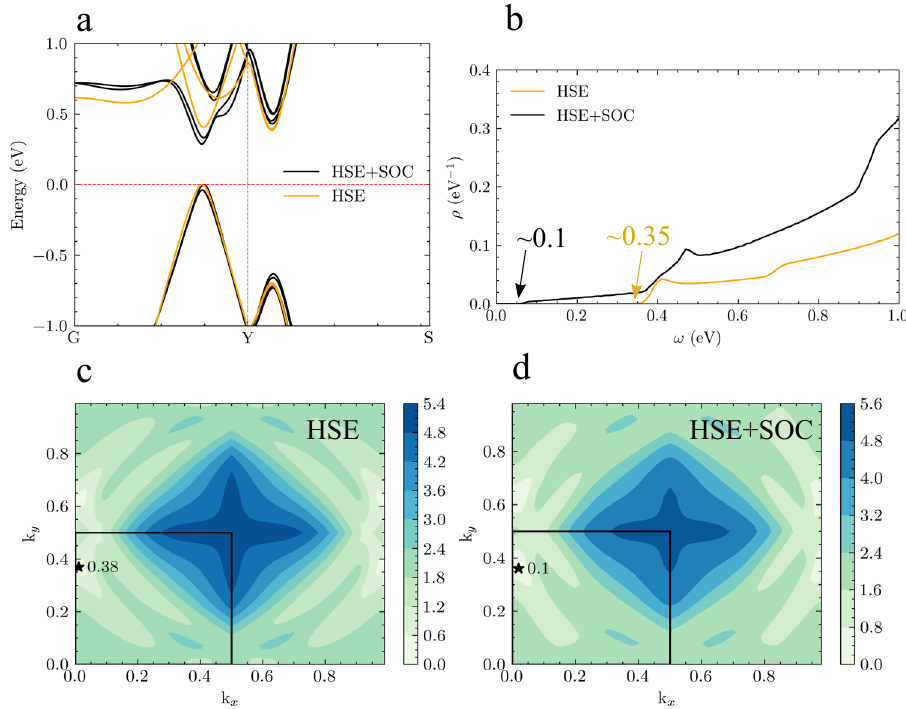
Fig. 7 Analysis of the electronic structure of monolayer Sb. a Zoomed-in band structures calculated with HSE and HSE + SOC. b Joint density of states. Contour plots of the energy difference between the highest valence band and the lowest conduction band over the whole 2D BZ obtained with c HSE and d HSE + SOC. The star symbol labels the direct band